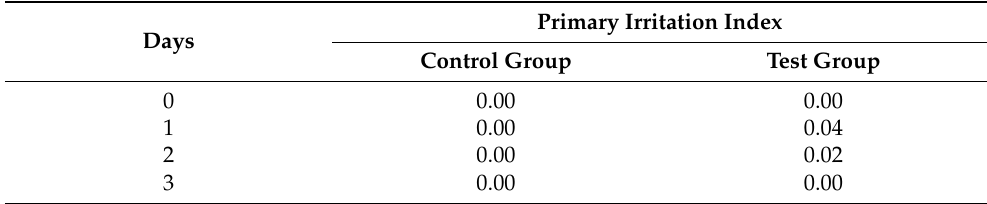
Table 9. Skin irritation scoring of control group and test group at different time